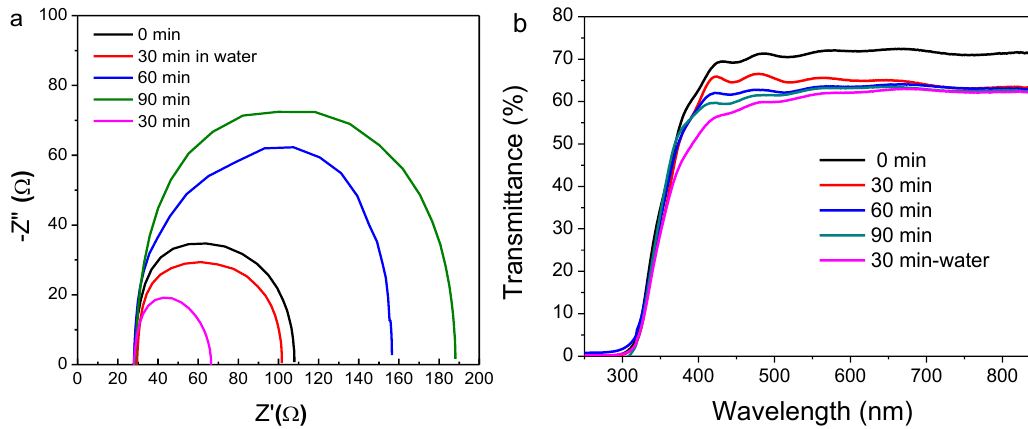
Figure 7. EIS curves of the assembled PSCs ( a ) and transmittance of TiCl 4 treated TiO 2 / FTO glass ( b ). The applied dc potential bias was changed by ∼ 50 mV steps from 500 to 0 mV.